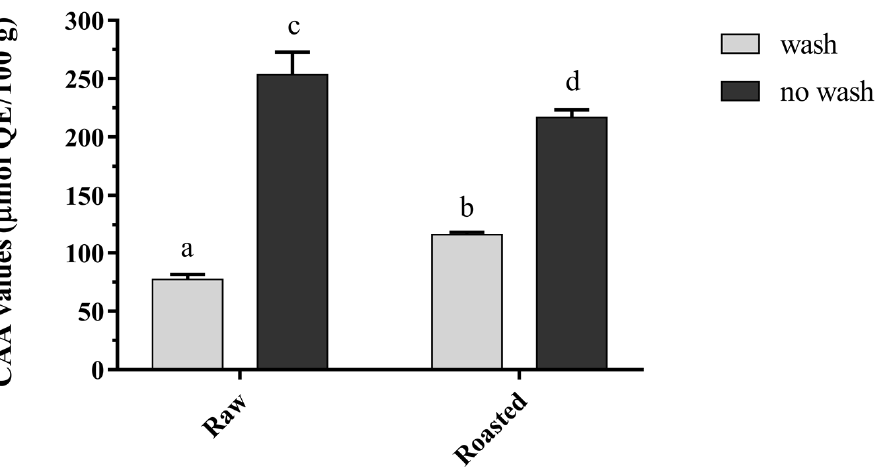
Figure 2. Cellular antioxidant activity (CAA) of pistachios (raw and roasted, free form). Values with different letters in each bar are contrasting ( p < 0.05) significantly. Table 4. Vitamin E and carotenoid profiles of pistachios (raw and roasted) (independent T-test).